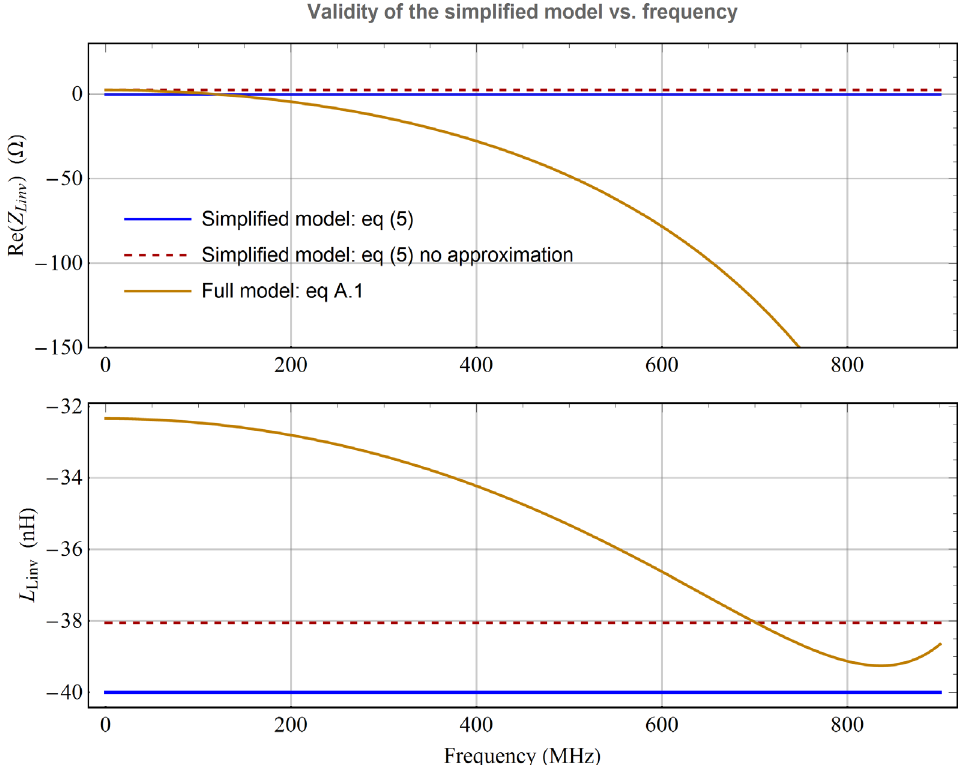
Fig. A.1. Comparison of the simpli fi ed and full model of the Linvill circuit from 100 to 900MHz. Circuit parameters are g m =20 mS, R =100 V , and L =40 nH. (Top) Real part of the input impedance. (Bottom) Equivalent inductance of the input